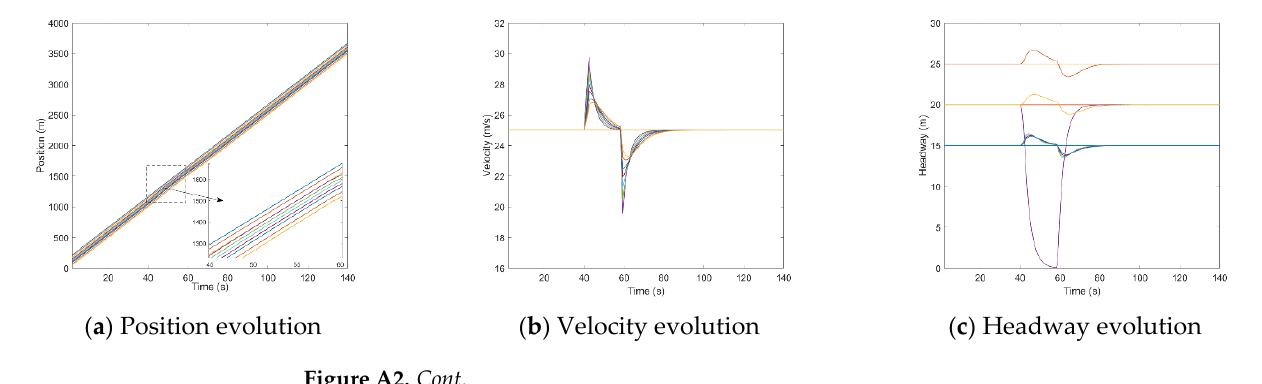
( f ) Headway evolution Figure A2. Mixed traffic flow evolution diagrams under the overestimated position with/without RRCS in PATH’s CACC car− following models.. Without RRCS ( a ) Position evolution